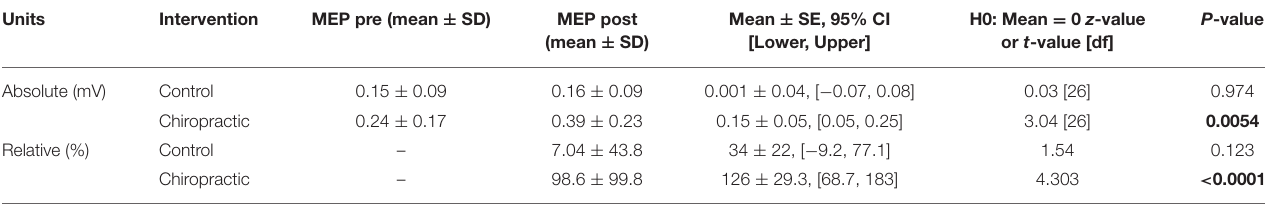
TABLE 3 | Within-group MEP amplitude differences.